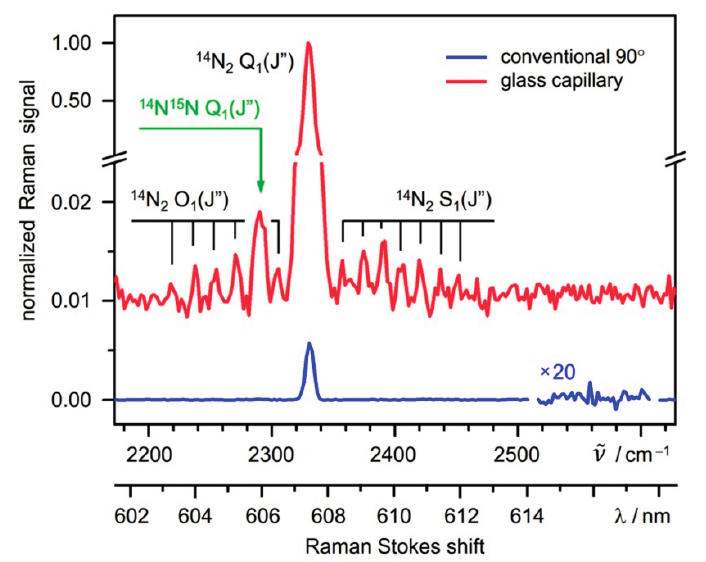
Figure 2. Raman spectra of nitrogen in ambient air, recorded in glass-capillary (  = 650 mm) and 90°-cell (  = 6 mm) experimental configurations; relevant spectral features